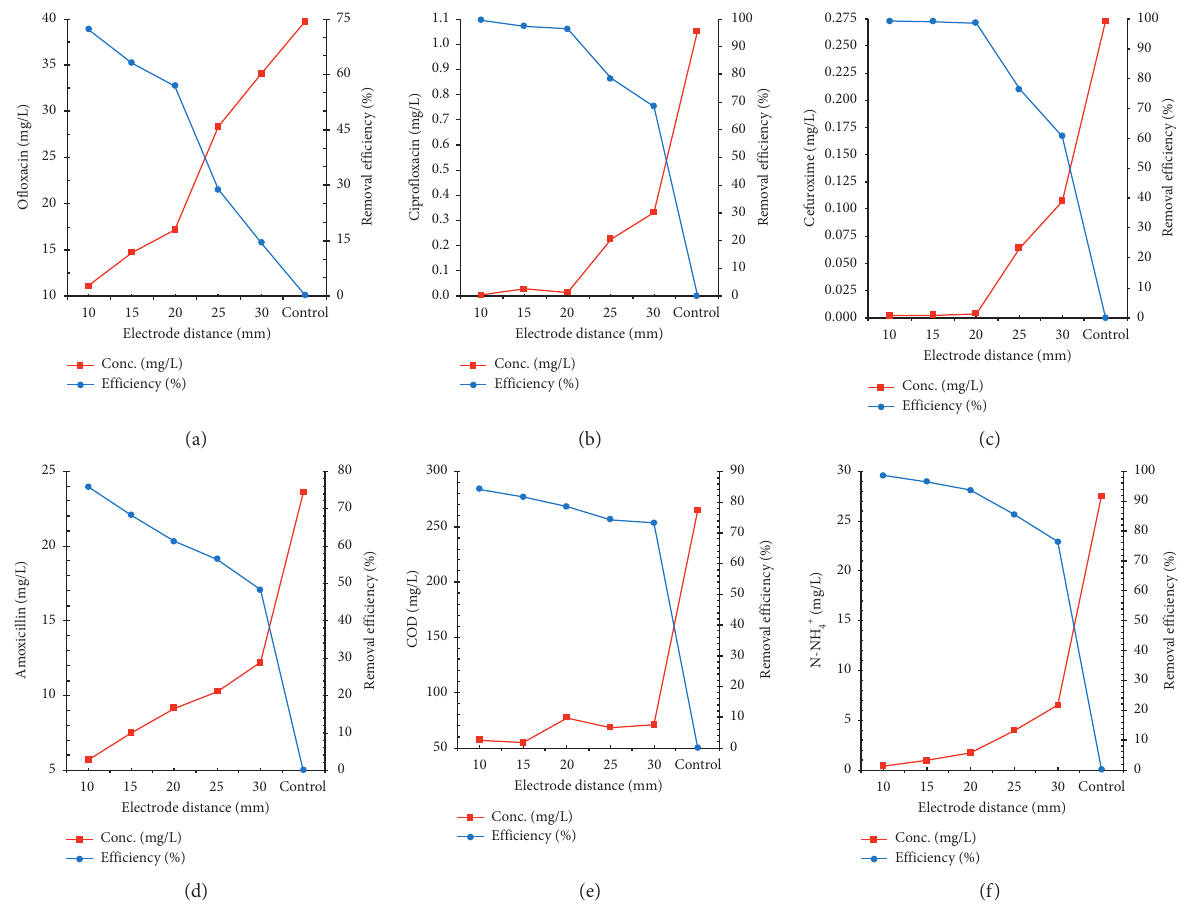
Figure 5: Effect of the interelectrode distance in the plasma reactor on the degradation efficiency of four antibiotics, namely, (a) ofloxacin, (b) ciprofloxacin, (c) cefuroxime and (d) amoxicillin, respectively, as well as (e) COD and (f) ammonia